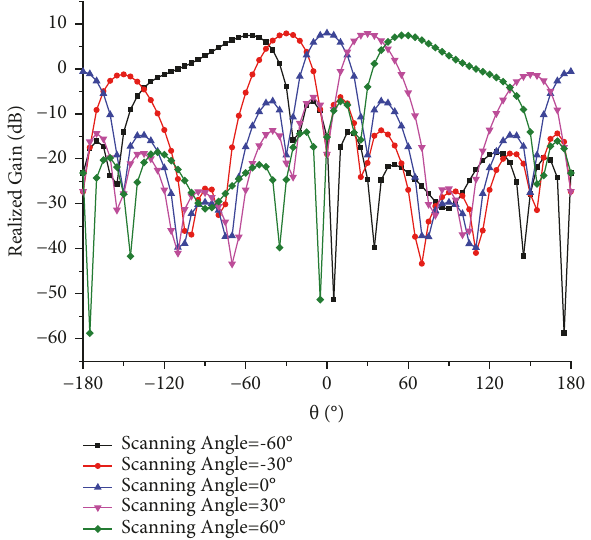
Figure 10: H-plane radiation patterns at 𝜃 = 0 ∘ , ±30 ∘ , ±60 ∘ of the DRA array at 7 GHz.